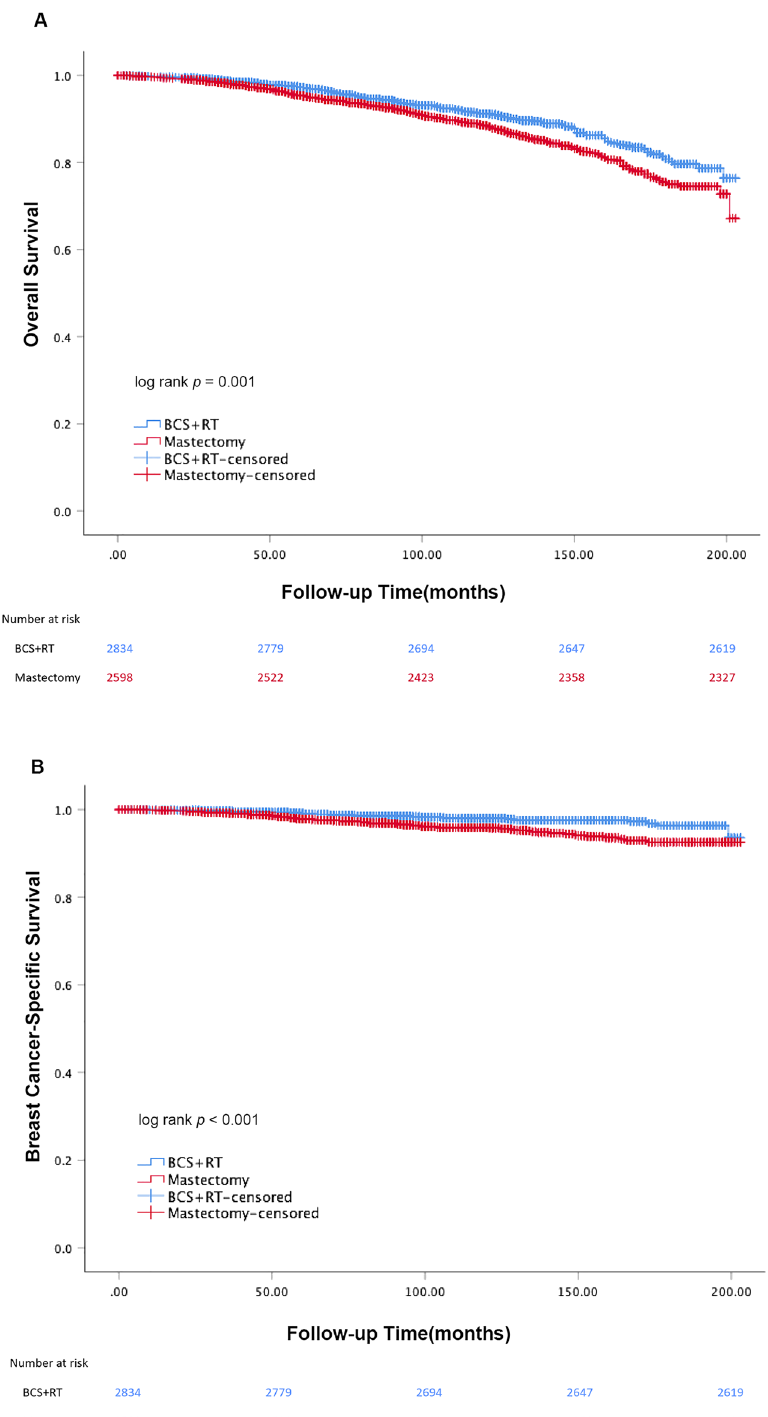
Figure 1. Kaplan–Meier curves of OS ( A ) and BCSS ( B ) for unmatched